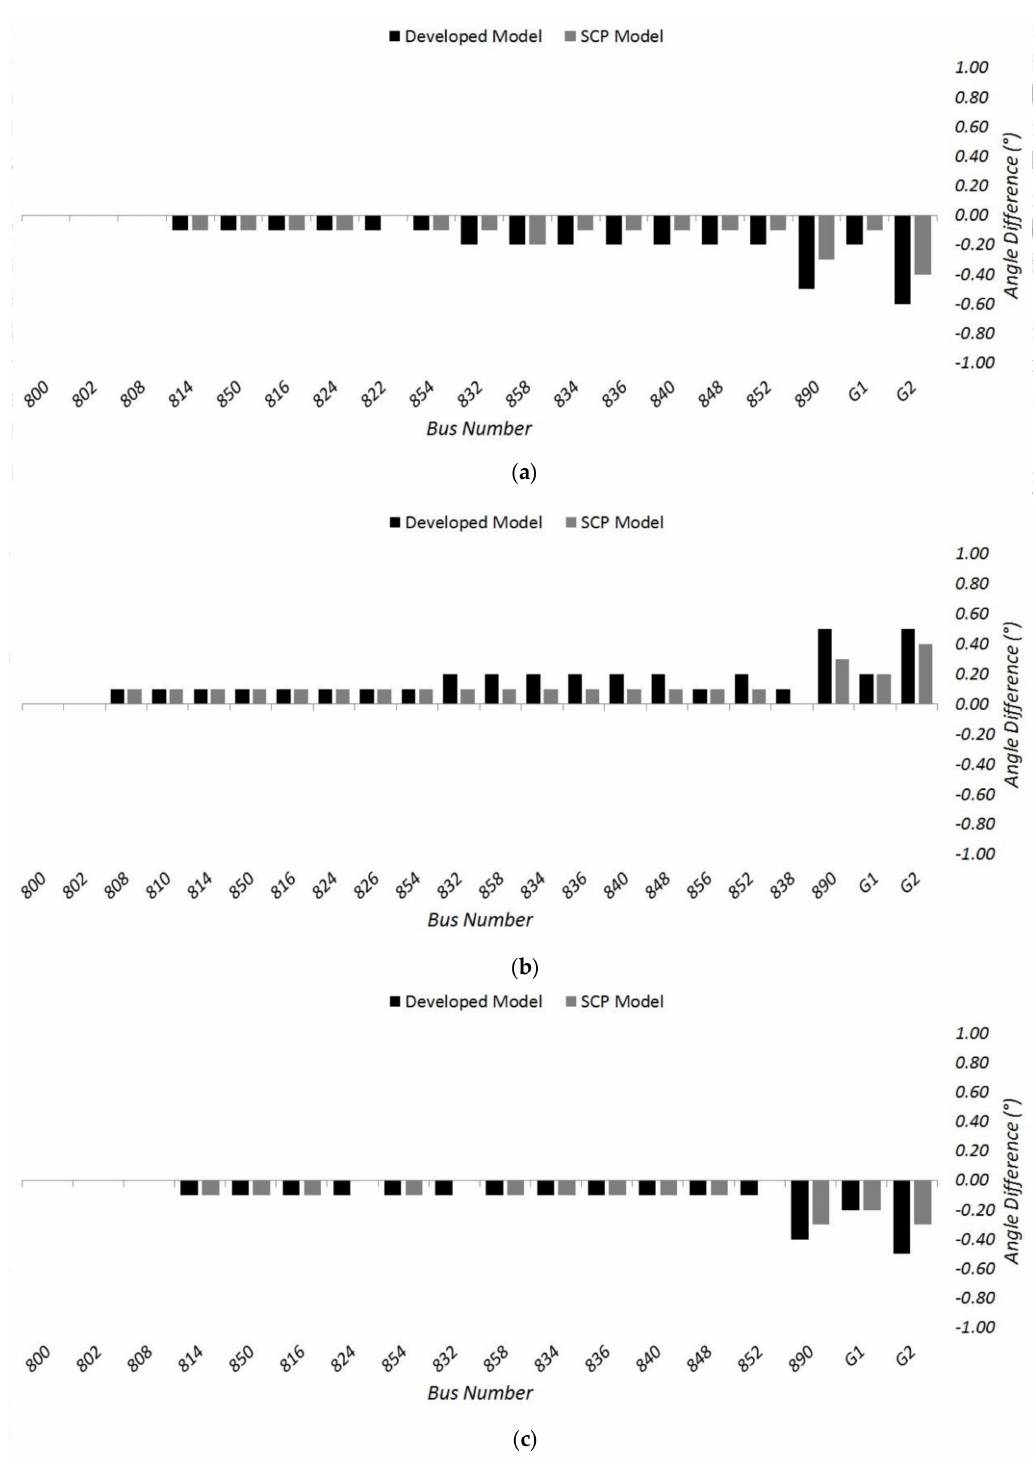
Figure 10. Voltage angle differences ( ◦ ) of each bus with models for ( a ) Phase A; ( b ) Phase B; and ( c ) Phase